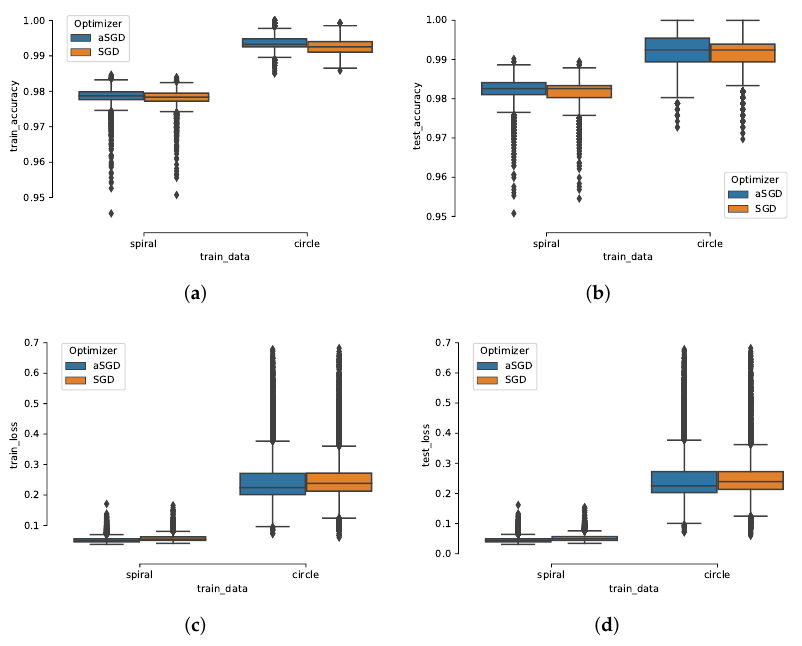
Figure 6. The boxplots of final ( a ) train accuracy, ( b ) test accuracy, ( c ) train loss and ( d ) test loss of Experiment 2.